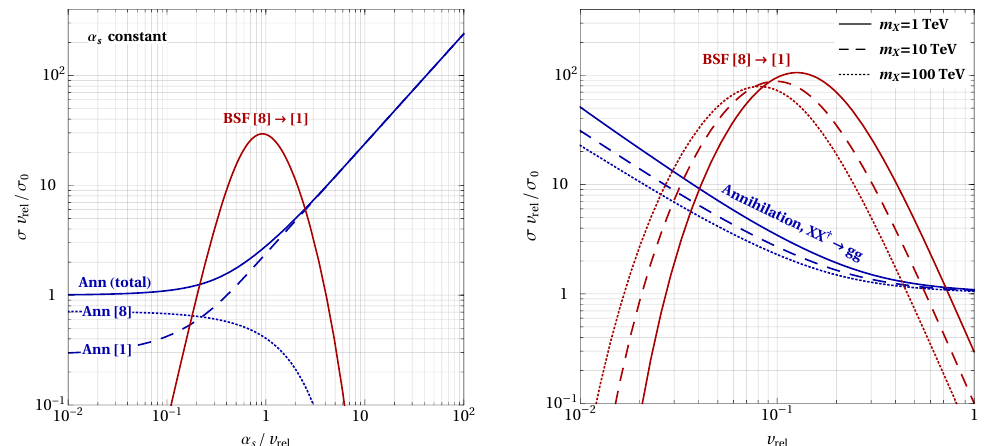
Figure 5. Left : the cross-sections times relative velocity for annihilation into gluons, XX y ! gg ( blue lines ), and radiative capture into the ground state ( red line ), normalised to the perturbative annihilation cross-section times relative velocity (cid:27) 0 (cid:17) 14 (cid:25)(cid:11) 2 dotted lines denote the contributions of the colour-singlet and the colour-octet scattering states in the total annihilation cross-section. We have ignored here the running of the strong coupling, which implies that (cid:27)v rel =(cid:27) 0 depend only on (cid:11) s =v rel . Right : the cross-sections times relative velocity for annihilation into gluons, XX y ! gg ( blue lines ), and radiative capture into the ground state ( red line ), normalised to (cid:27) 0 . The lines corresponding to di(cid:11)erent values of m of the strong